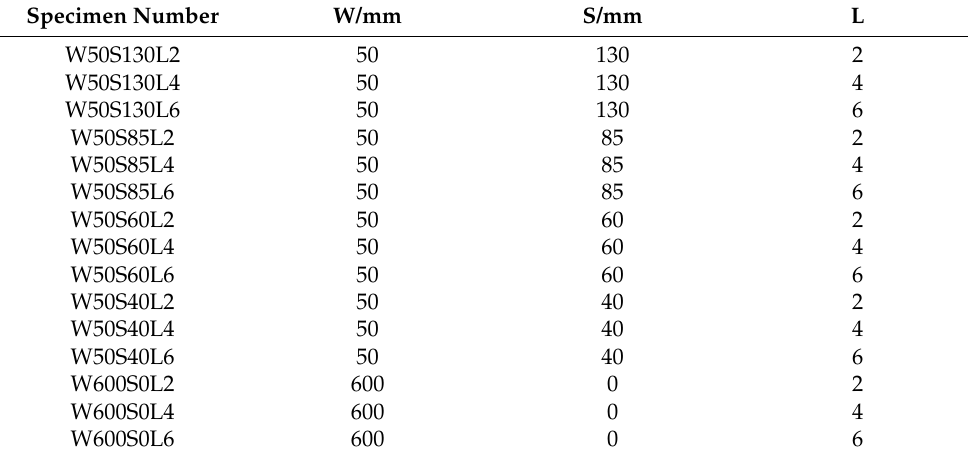
Table 8. Design parameters of the finite element model.